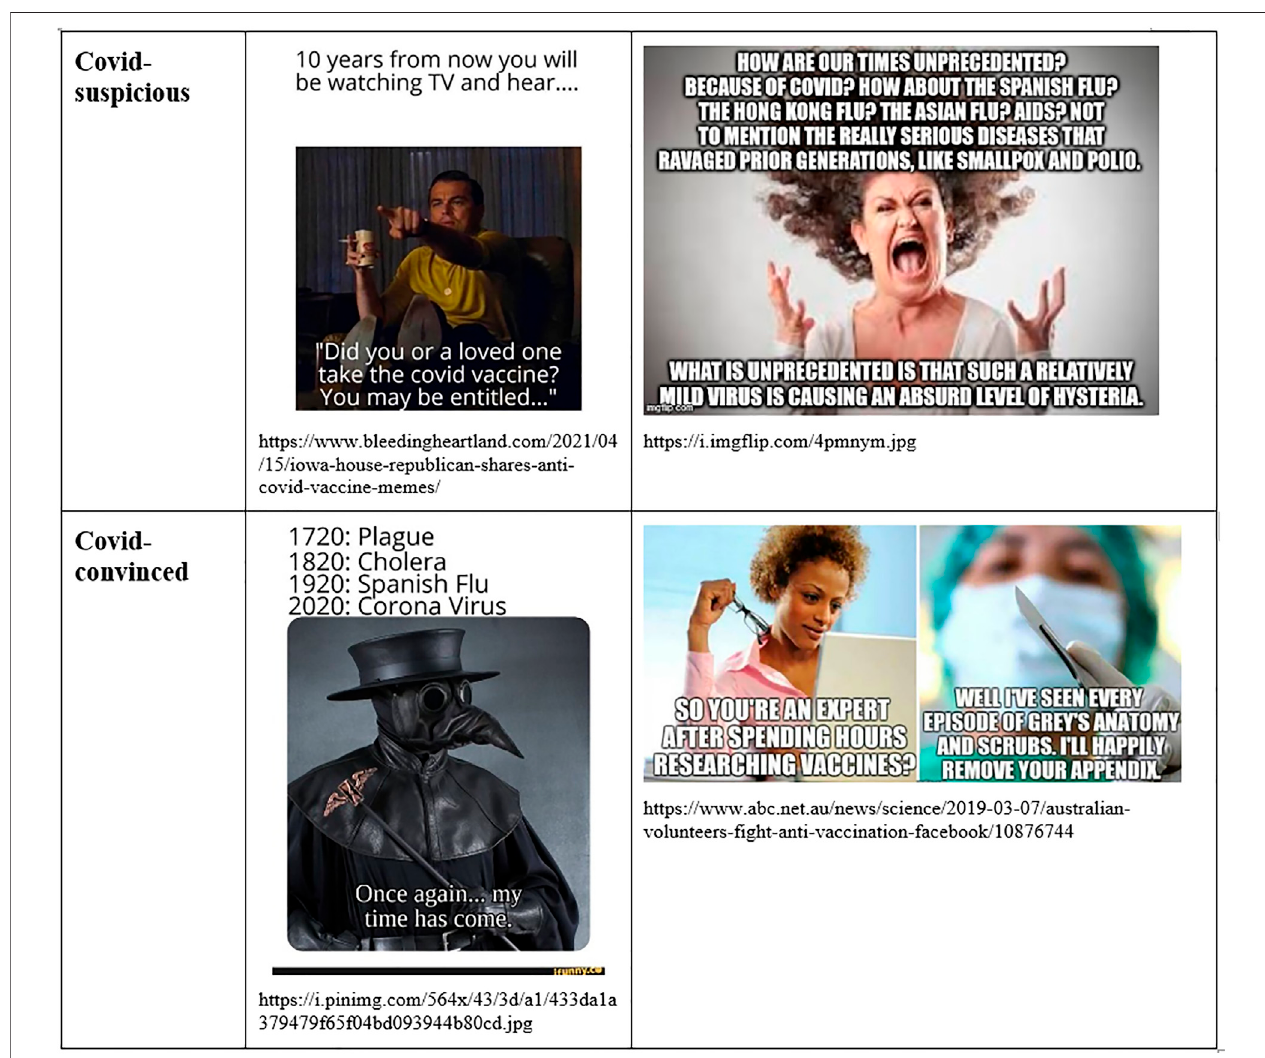
FIGURE 7 | Time work in Covid-suspicious and Covid-convinced memes.